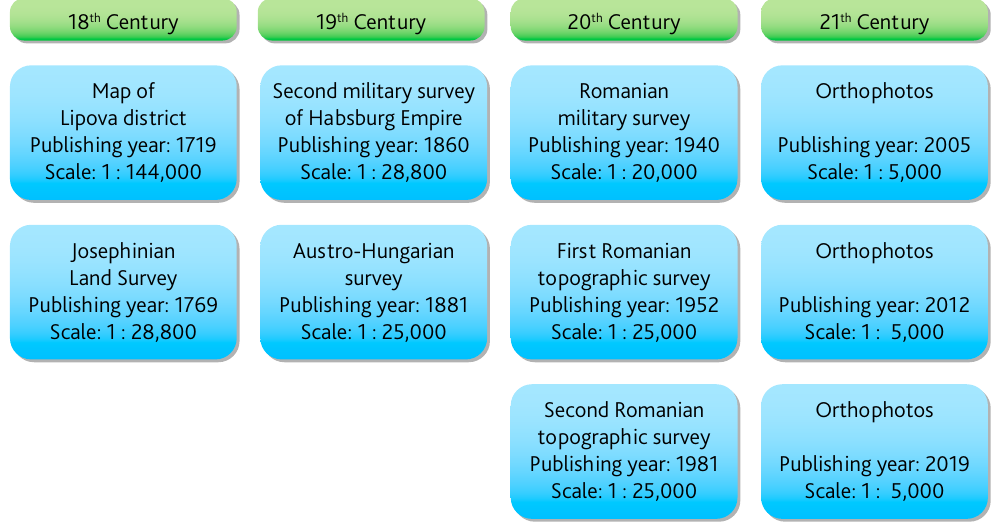
Figure 5. Cartographic data sources grouped by century